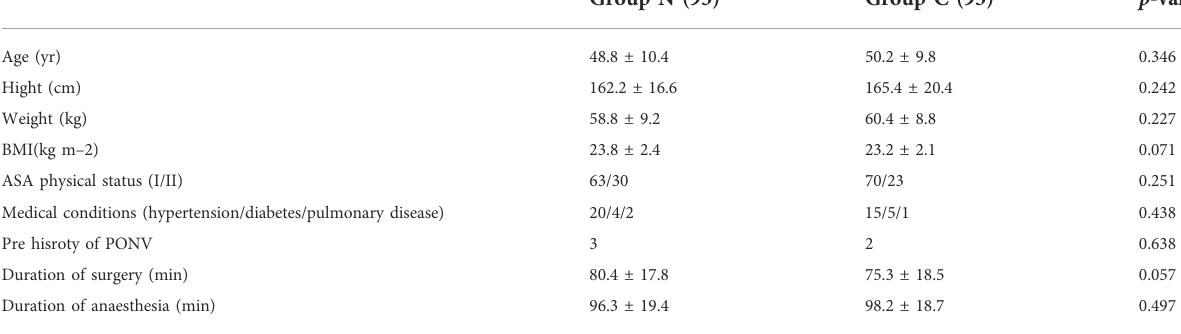
TABLE 1 Demographic characteristics of the patients between the two groups.